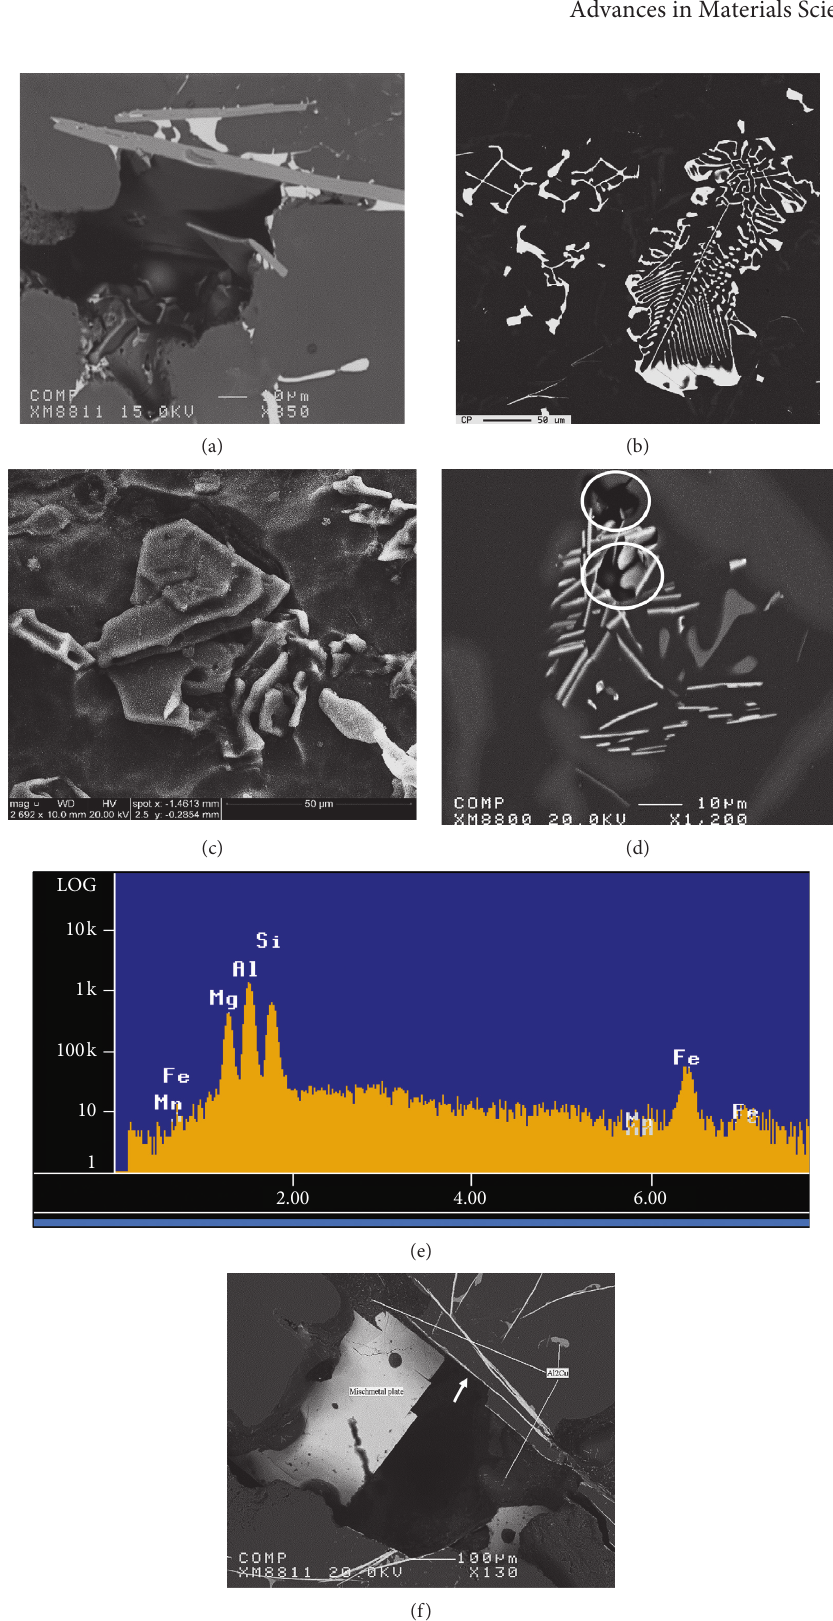
Figure 16: Backscattered electron images of shrinkage porosity in B319 + 0.8%Fe showing the following: (a) β -platelets, (b) α -Fe-polished sample, (c) α -Fe-fracture surface, (d) π -Fe, and (e) EDS spectrum corresponding to (d) showing reflections due to Al, Si, Mg, and Fe and (f) rare earth metal platelet-white arrow indicates the restriction of pore growth same as β -Fe